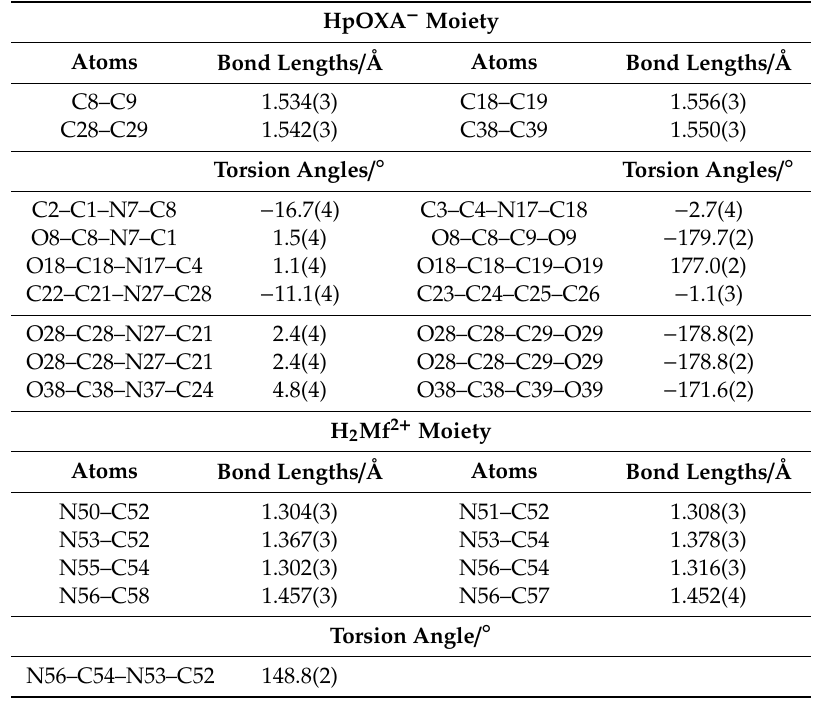
Table 1. Selected bond lengths and torsion angles of the organic salt H 2 Mf(HpOXA) 2 ·